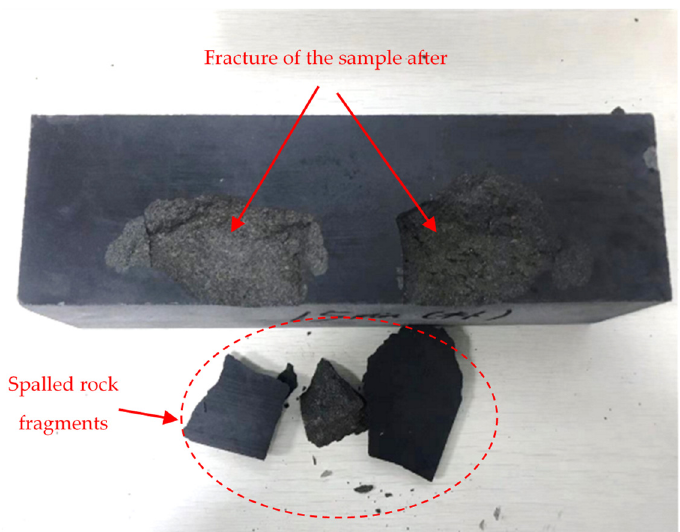
Figure 7. Bursting and fracturing of the sample after microwave irradiation .